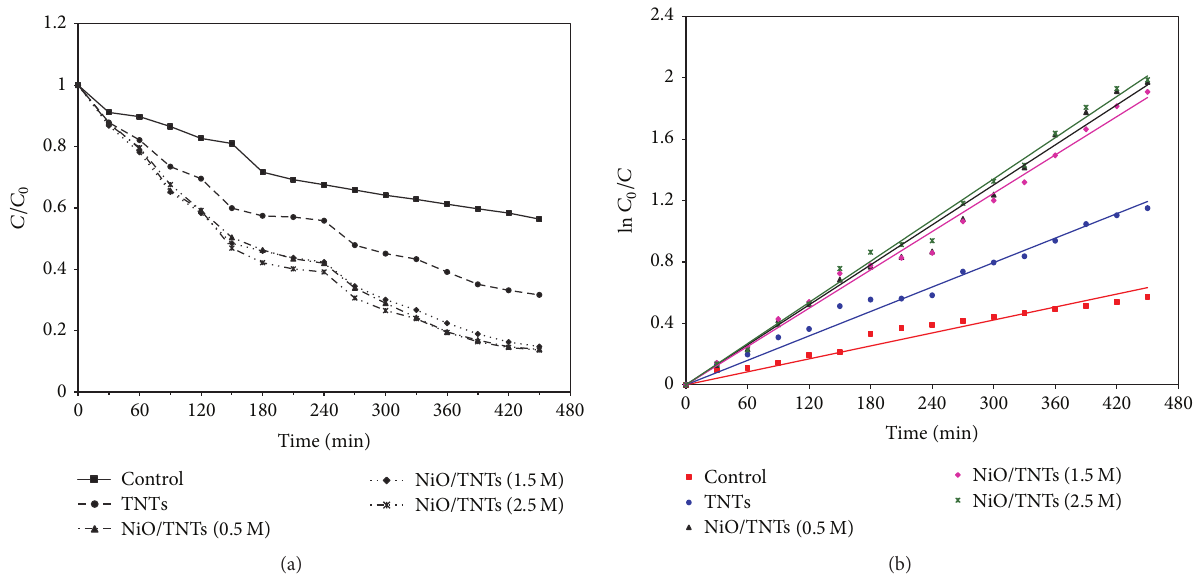
Figure 7: (a) Photocatalytic degradation of MB over TNTs samples with varying NiO concentrations under solar light irradiation and (b) kinetic plot of TNTs samples with varying NiO concentrations.